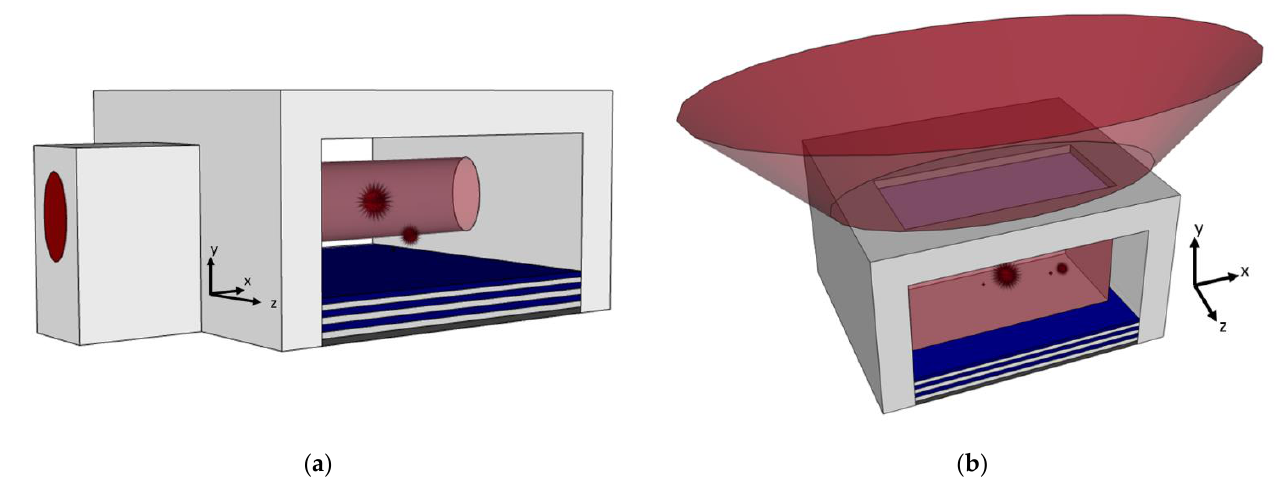
Figure 2. Conceptual examples of the two illumination formats under study, with the example illuminating light given in red: ( a ) A side-illuminated device has an optical mode guided by a ridge waveguide to the ARROW channel; ( b ) A top-illuminated device has a window through an opaque covering over the ARROW channel, and an illuminating light is spread over the window.